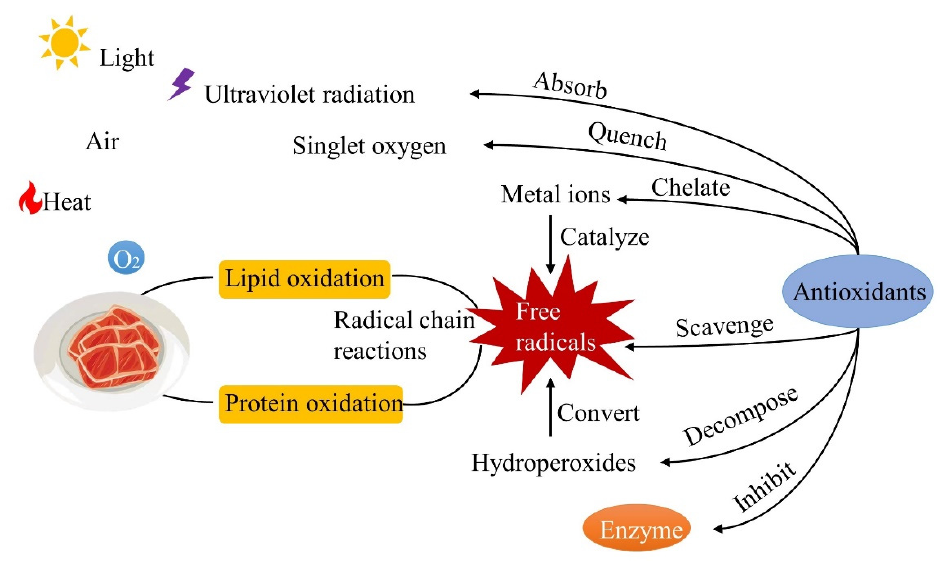
Figure 4. Antioxidant mechanism on meat preservation.